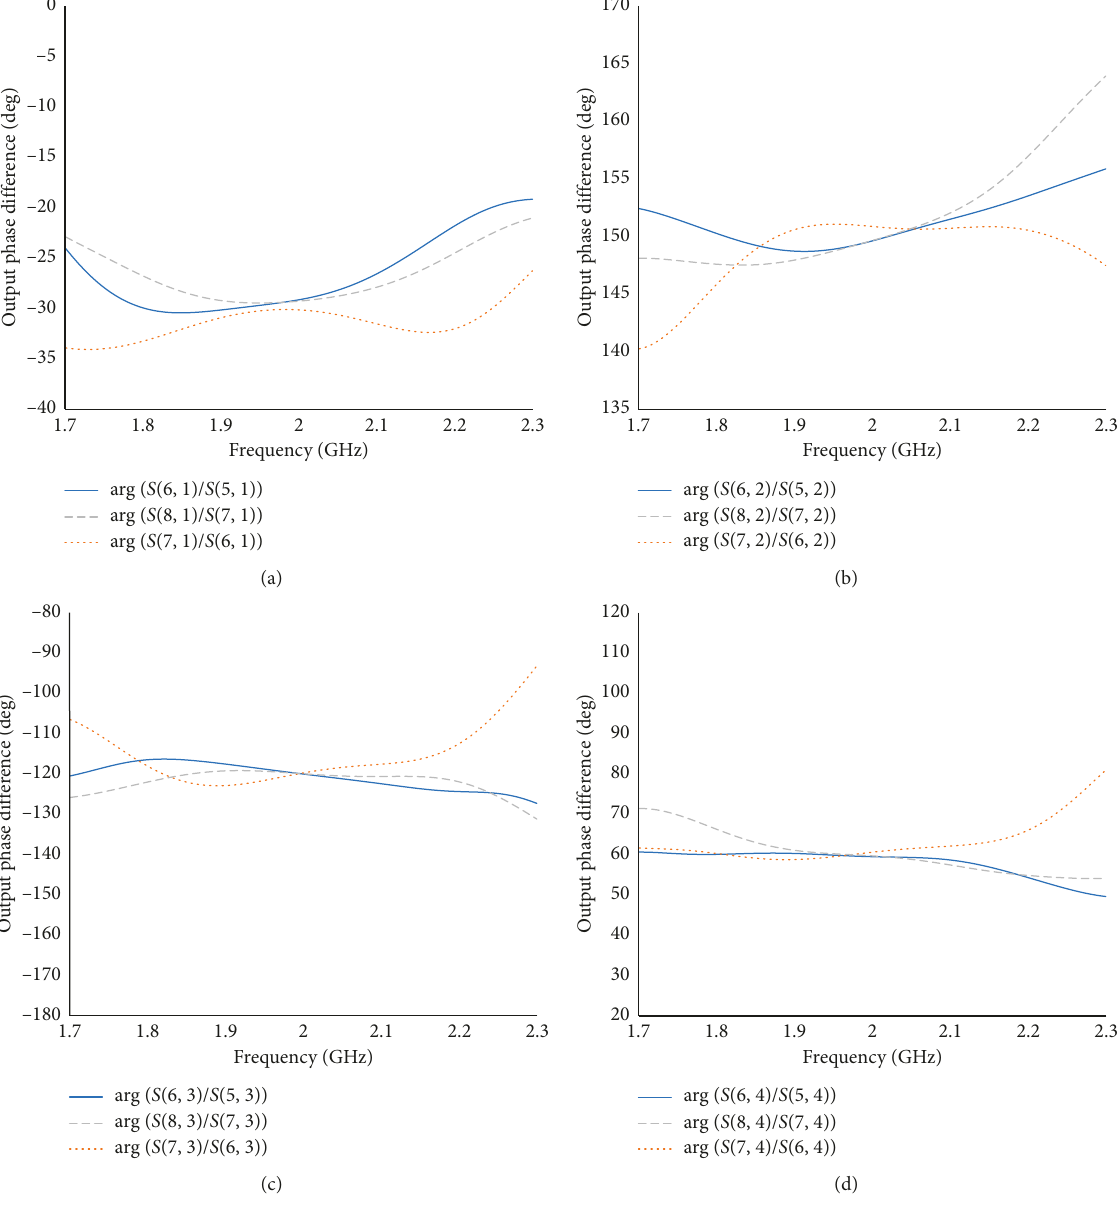
Figure 8: Output phase difference of the Butler matrix when: (a) port 1 is excited; (b) port 2 is excited; (c) port 3 is excited; (d) port 4 is